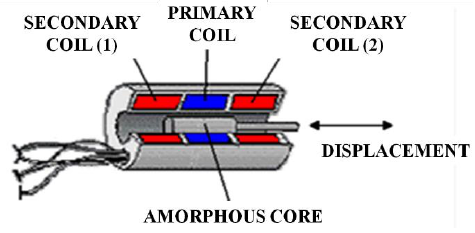
Figure 14. LVDT experimental